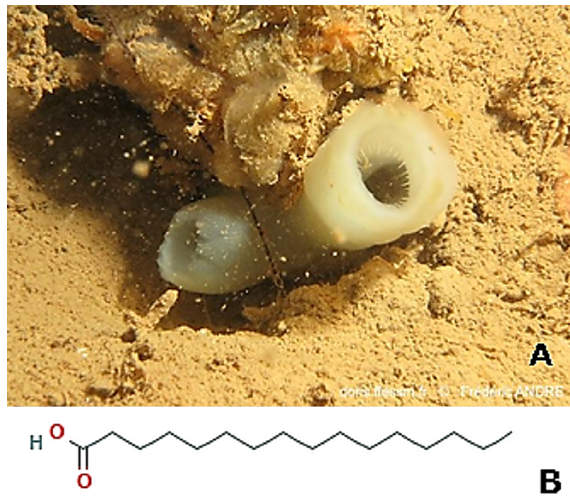
Figure 29. ( A ) An image of Phallusia arabica . © Fr é d é ric Andr é ; https: // doris. ff essm.fr / . ( B ) 2D Figure 29. A ) An image of Phallusia arabica . © Frédéric André; https://doris.ffessm.fr/. B ) 2D structure of n-hexadecanoic acid; https: // pubchem.ncbi.nlm.nih.gov / compound / Palmitic-acid#section = structure of n-hexadecanoic acid; https://pubchem.ncbi.nlm.nih.gov/compound/Palmitic-acid# section=2D-Structure.